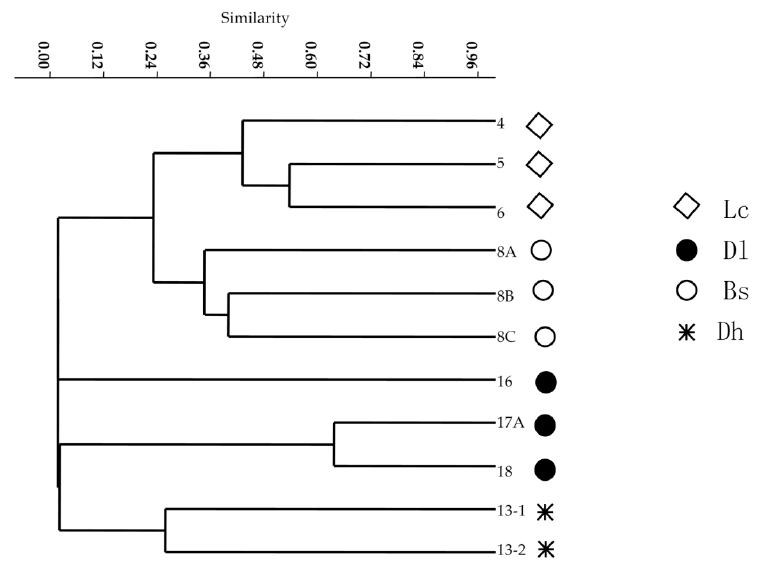
Figure 6. Cluster analyses of the culturable Thermus -like bacterial community structure in the hot springs of four geothermal regions based on Bray–Curtis similarity. The PCA plot indicated that OTU 1 ( T. oshimai ) and OTU 11 ( Meio. ruber ) preferred to inhabit the hot springs of the Bs geothermal region rather than the hot springs of the Lc, Dh and Dl geothermal regions (Figure 7). For example, OTU 1 ( T. oshimai ) accounted for 16.3% and 2.2% of the culturable Thermus- like bacteria in the Lc and Dl hot springs, re-